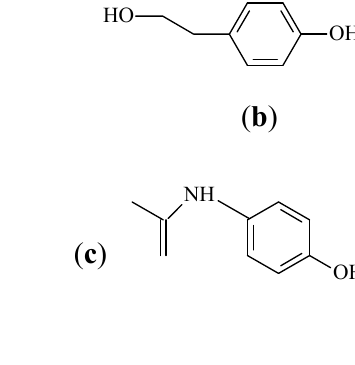
Figure 1. Chemical structures of ( a ) salidroside; ( b ) p- tyrosol; and ( c ) paracetamol